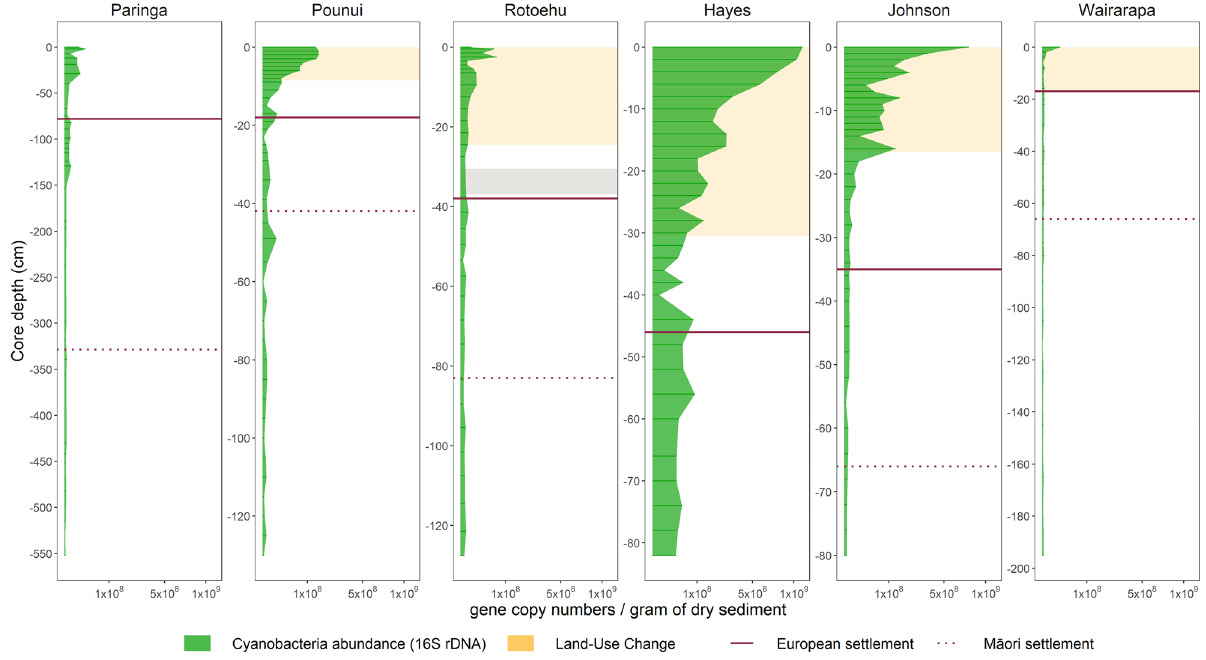
Figure 3. Cyanobacterial concentrations from droplet digital PCR data. Sediment depth profiles of cyanobacterial 16S rRNA gene copy numbers per gram of dry sediment, y-axis shown on square-root scale. The horizontal lines separate the three phases, pre-human (PH; bottom), evidence of Māori arrival (EMS; middle), and post European arrival (PES; top); note: the sediment core from Lake Hayes does not include any PH phase. Yellow shades indicate the depths associated with land-use intensification in relevant lakes, the grey shade indicates the 1886 Tarawera tephra layer in Lake Rotoehu.